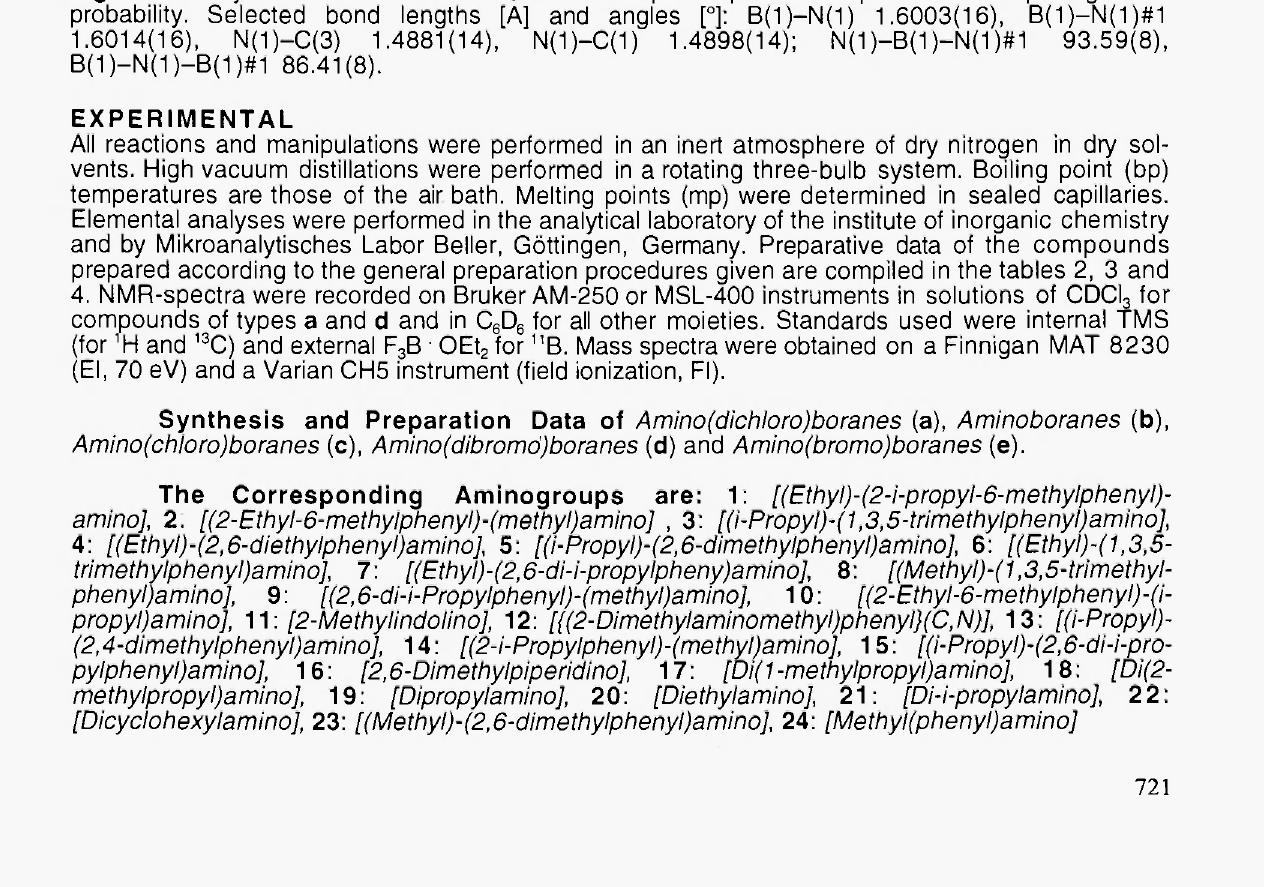
Figure 3. Crystal structure of 20b with anisotropic displacement parameters depicting 50% probability. Selected bond lengths [A] and angles [°]: B(1)-N(1)